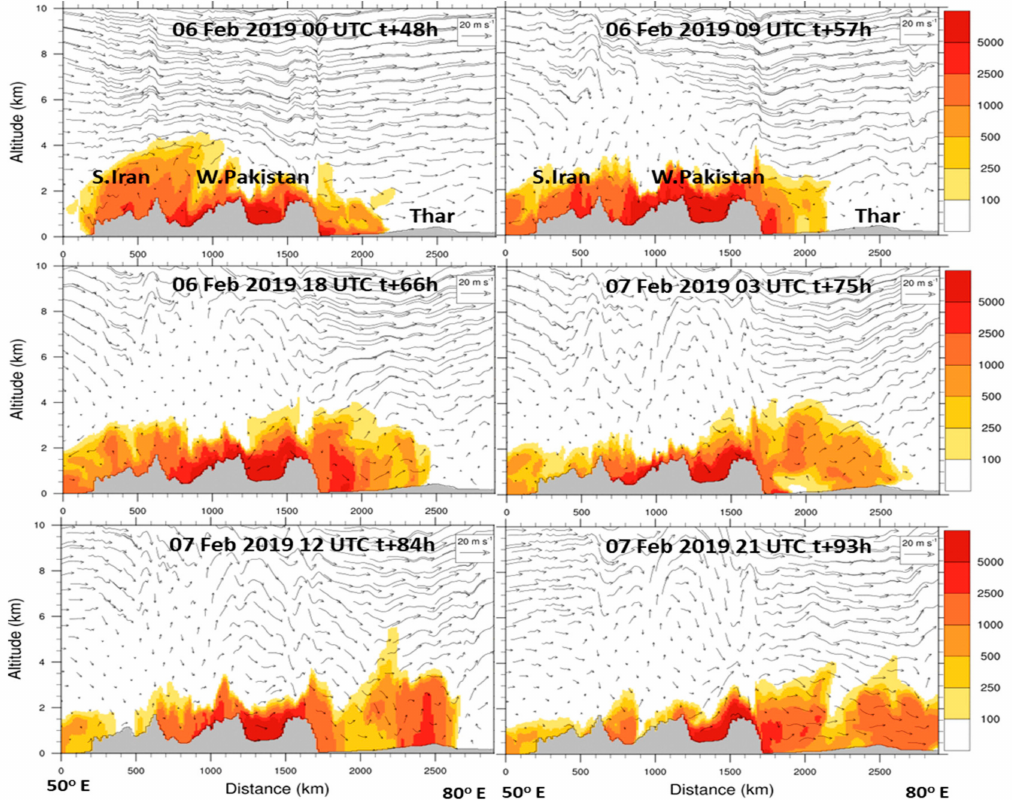
Figure 9. Vertical cross sections of dust concentration (in µ g m − 3 ) from 50 ◦ E to 80 ◦ E along 28 ◦ N (black line in Figure 8) for certain hours during 5–7 February 2019 (LST = UTC + 5.30). The winds along the cross sections are superimposed in vectors. The distance is in km starting from 50 ◦